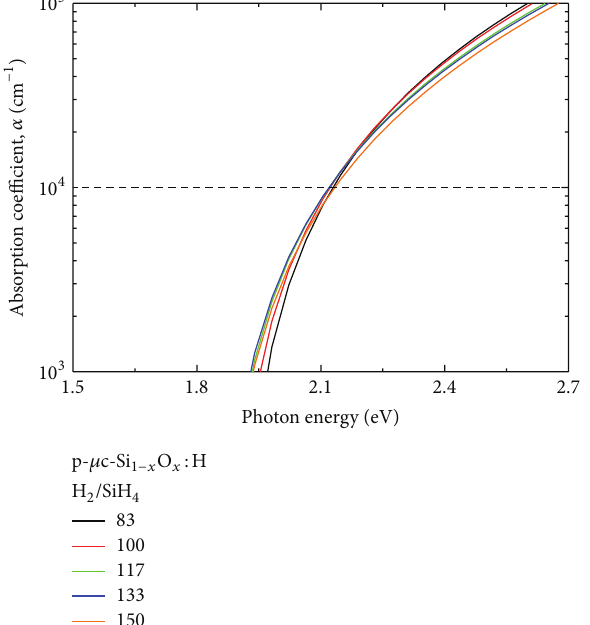
Figure 6: Dependence of the absorption coefficient on the H 2 /SiH 4 ratio for p- 𝜇 c-Si 1−𝑥 O 𝑥 :H films.